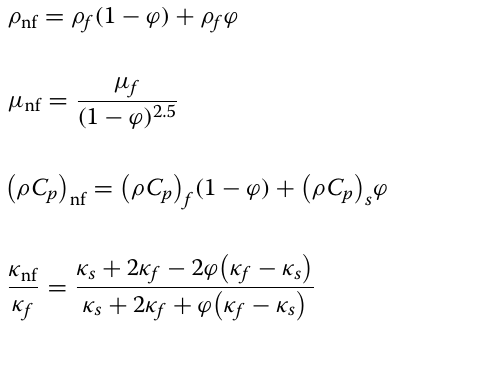
Table 1 Thermo-physical properties of water and nanoparticles Material Density ( ρ ) C p (J/Kg.k) β (kg/m 3 ) Pure water 997.1